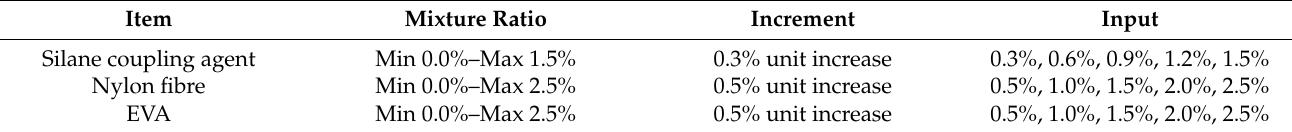
Table 5. Single additive mixture